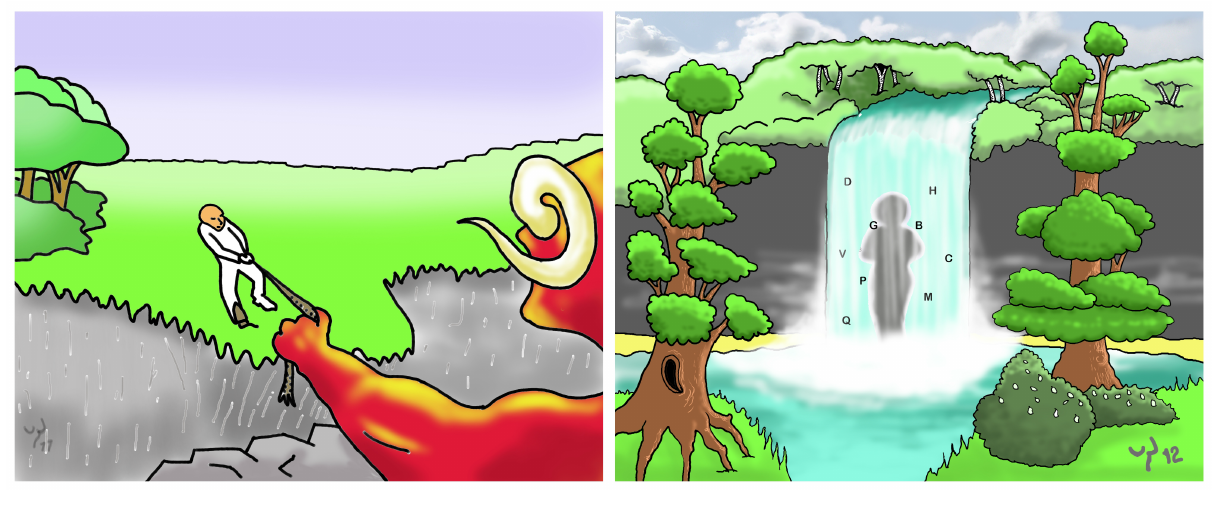
Figure 4. Examples of illustrated ACT metaphors. (Left, acceptance metaphor: tug of war. Try to stop your attempts of solving your pain by winning the war with it; try to let go of the rope. Right, defusion metaphor: waterfall. Instead of getting carried away by your stream of thoughts, take a step back and observe